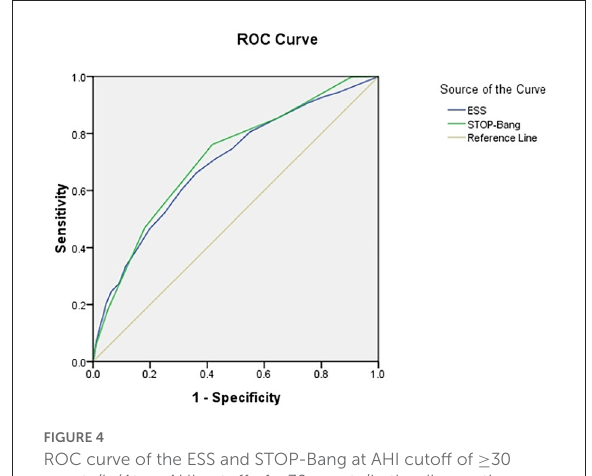
FIGURE4 ROC curve of the ESS and STOP-Bang at AHI cutoff of ≥ 30 events/h (At an AHI cutoff of ≥ 30 events/h, the diagnostic performance of the STOP-Bang is better than the ESS. AHI, apnea-hypopnea index; ESS, Epworth Sleepiness Scale; STOP-Bang, STOP-Bang questionnaire; ROC, receiver operating characteristic).